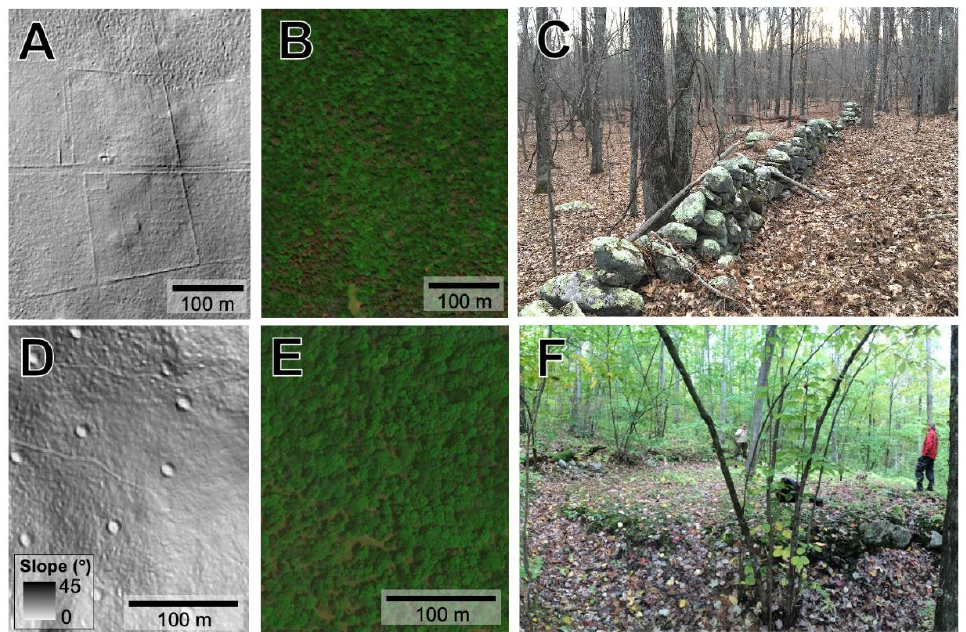
Figure 2. ( A , D ) depict examples of extant historical land use features as seen in LiDAR DEM derivatives (( A ) shows stone walls in a hillshaded DEM while (D) shows relict charcoal hearths in a slope raster). ( B , E ) depict current land cover (dense forest) in high-resolution aerial photography for those same extents, and ( C , F ) show examples of those feature types as they appear in the field.